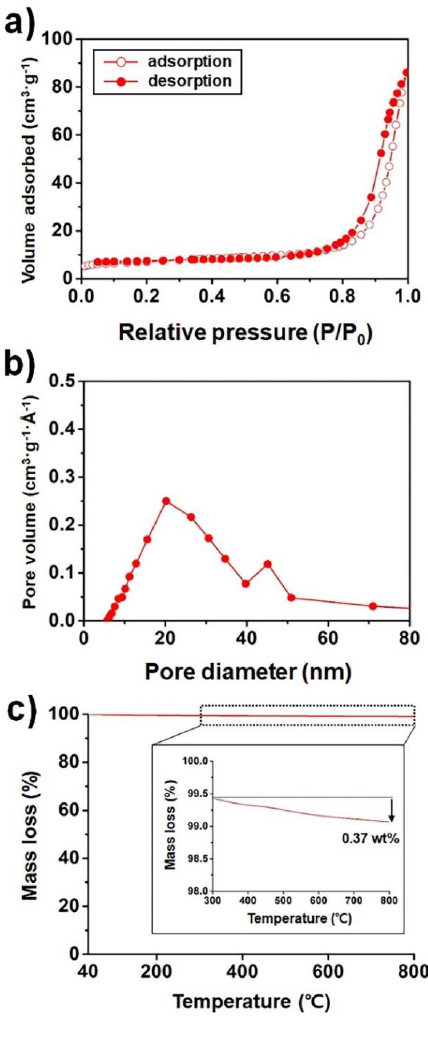
Figure 2. ( a ) N 2 sorption isotherms; ( b ) pore size distribution diagram; ( c ) TG curve of 0.2% Pt/m-Fe 2 O 3